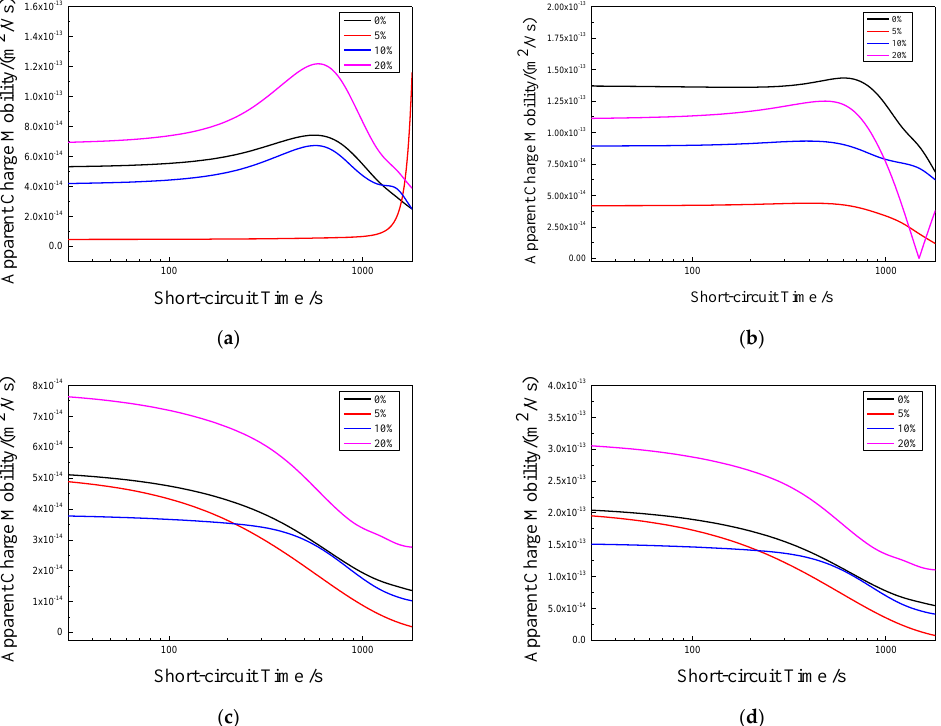
Figure 13. Apparent charge mobility curve of each sample. ( a ) Sample 1; ( b ) Sample 2; ( c ) Sample 3; ( d ) Sample 4.